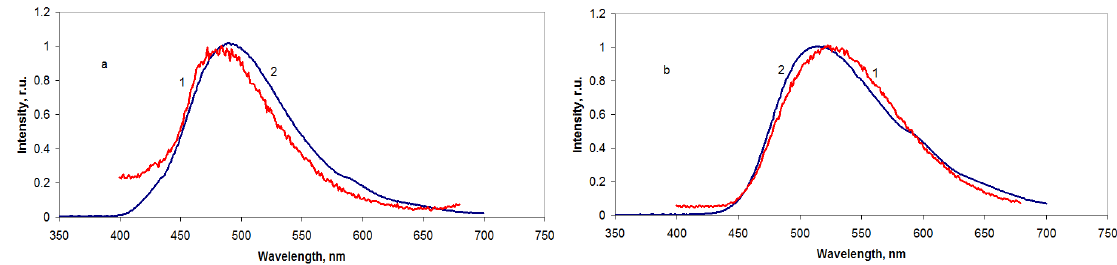
Figure 5. PL (1) and EL (2) spectra of complexes 5 ( a ) and 6 ( b